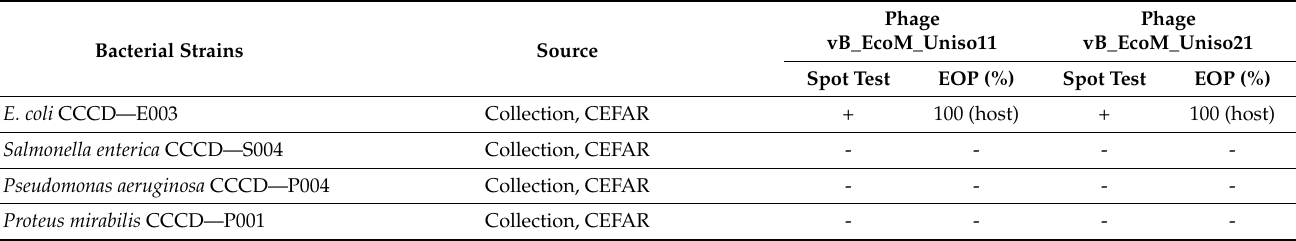
Table 1. Host range of the two newly isolated phages determined on 41 bacterial strains. Clear